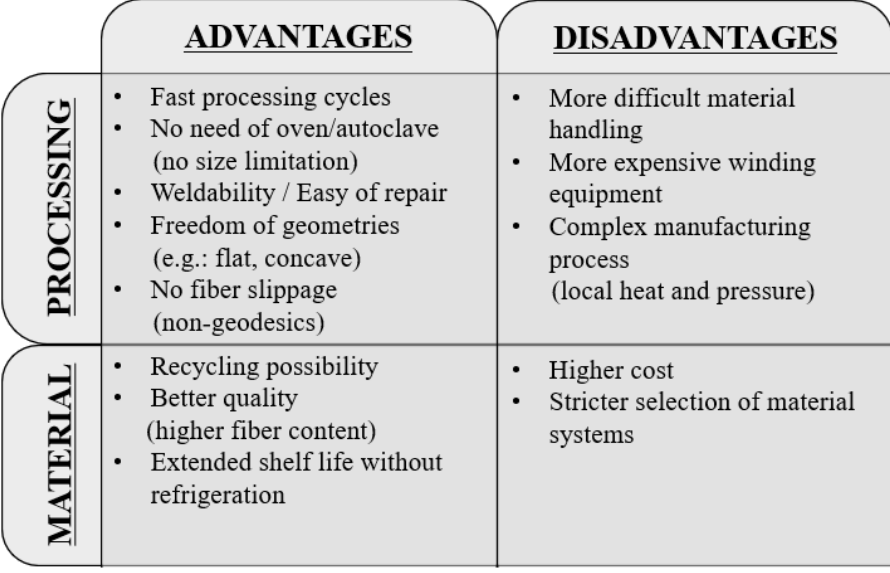
Figure 4. Advantages and disadvantages of tape filament winding with thermoplastics in comparison with wet filament winding with